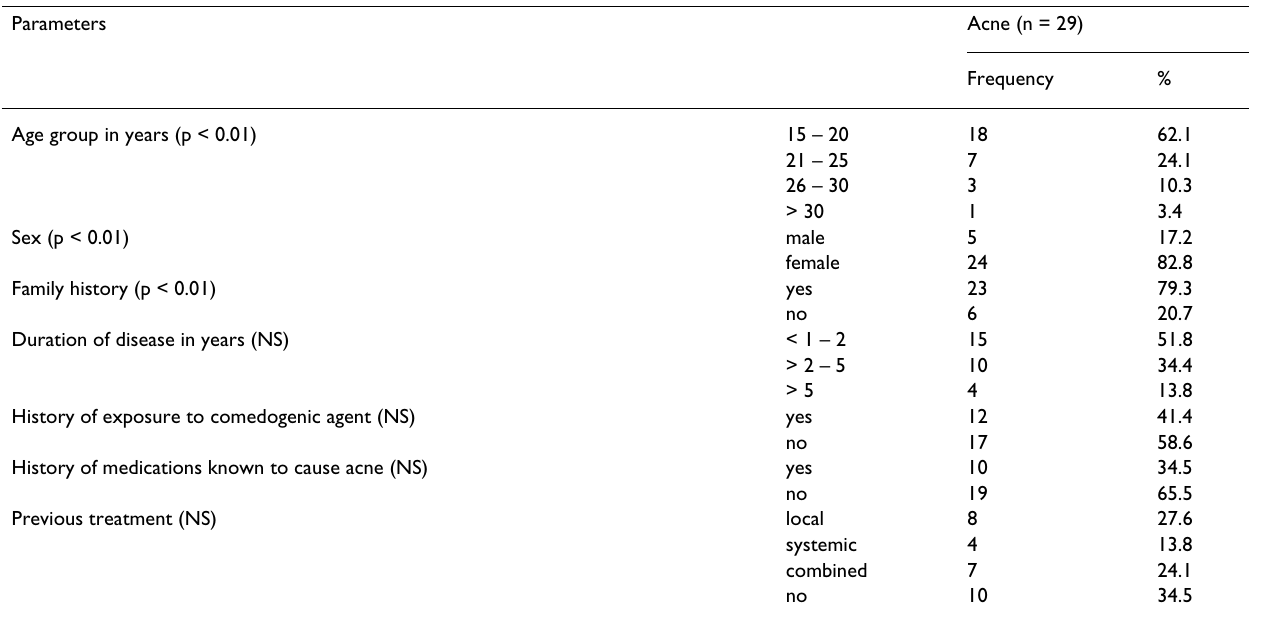
Table 1: Clinical characteristics of the study population.